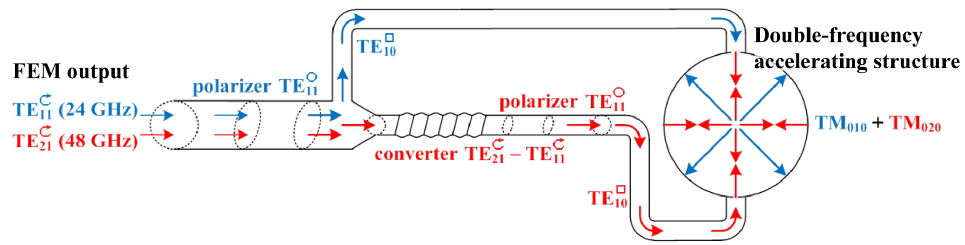
FIG. 5. Scheme of the planned experiment on testing a double-frequency accelerating structure by means of the FEM multiplier based on